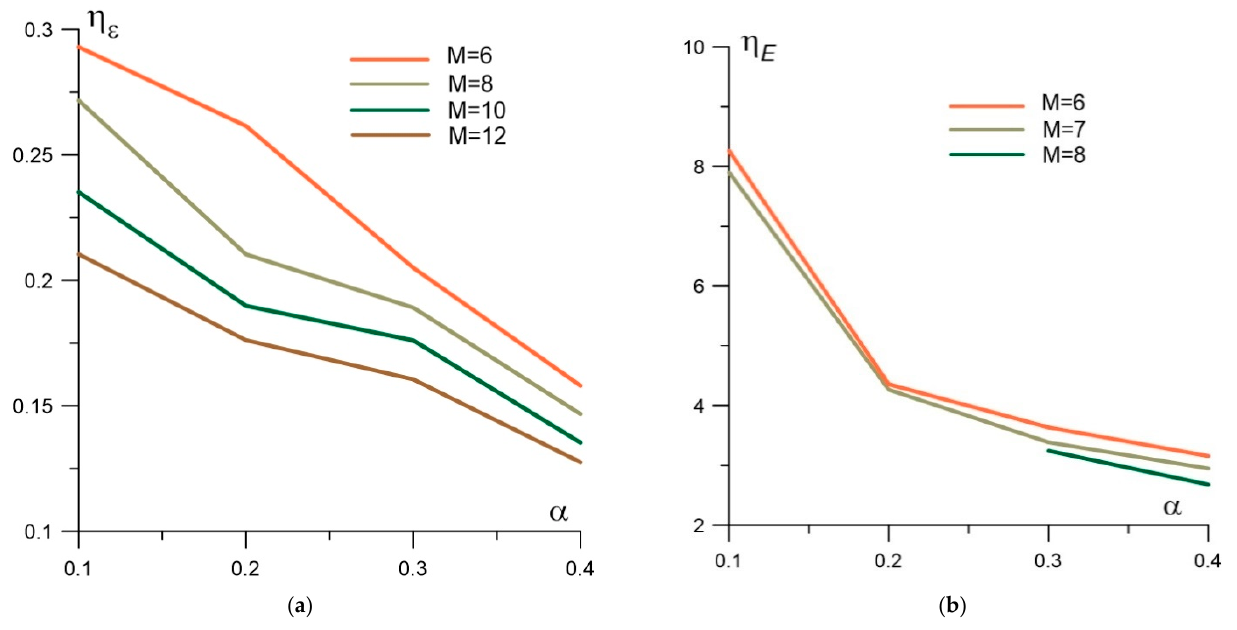
Figure 15. Efficiency on ε ( a ) and E ( b ) for different M and α .